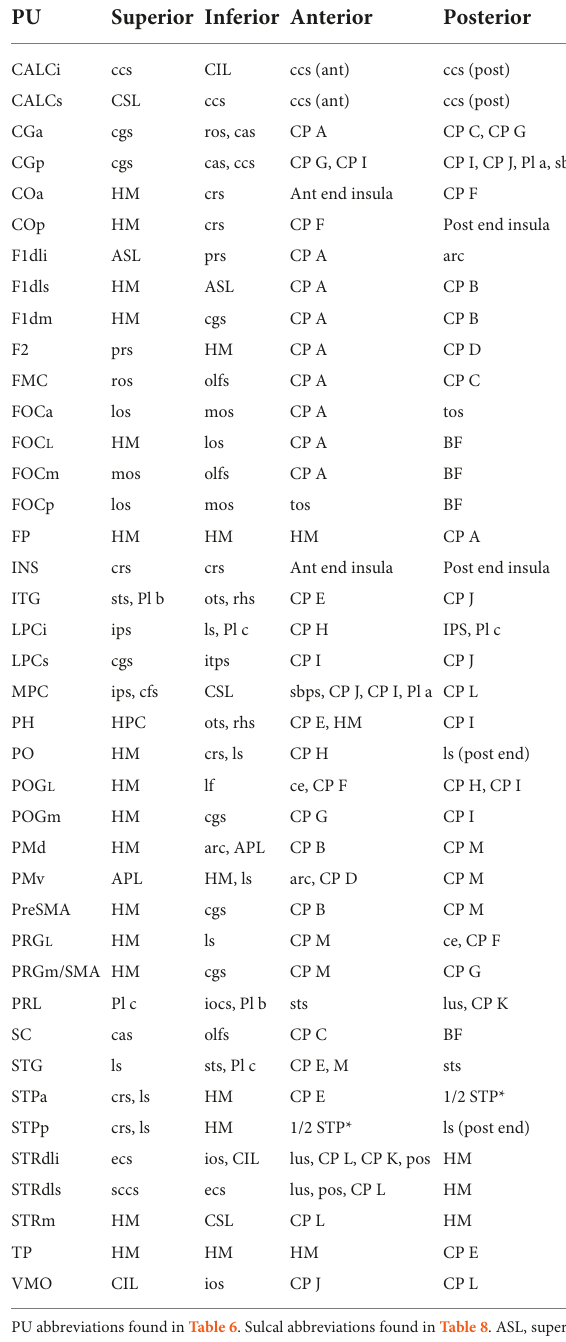
PU abbreviations found in Table 6 . Sulcal abbreviations found in Table 8 . ASL, superior